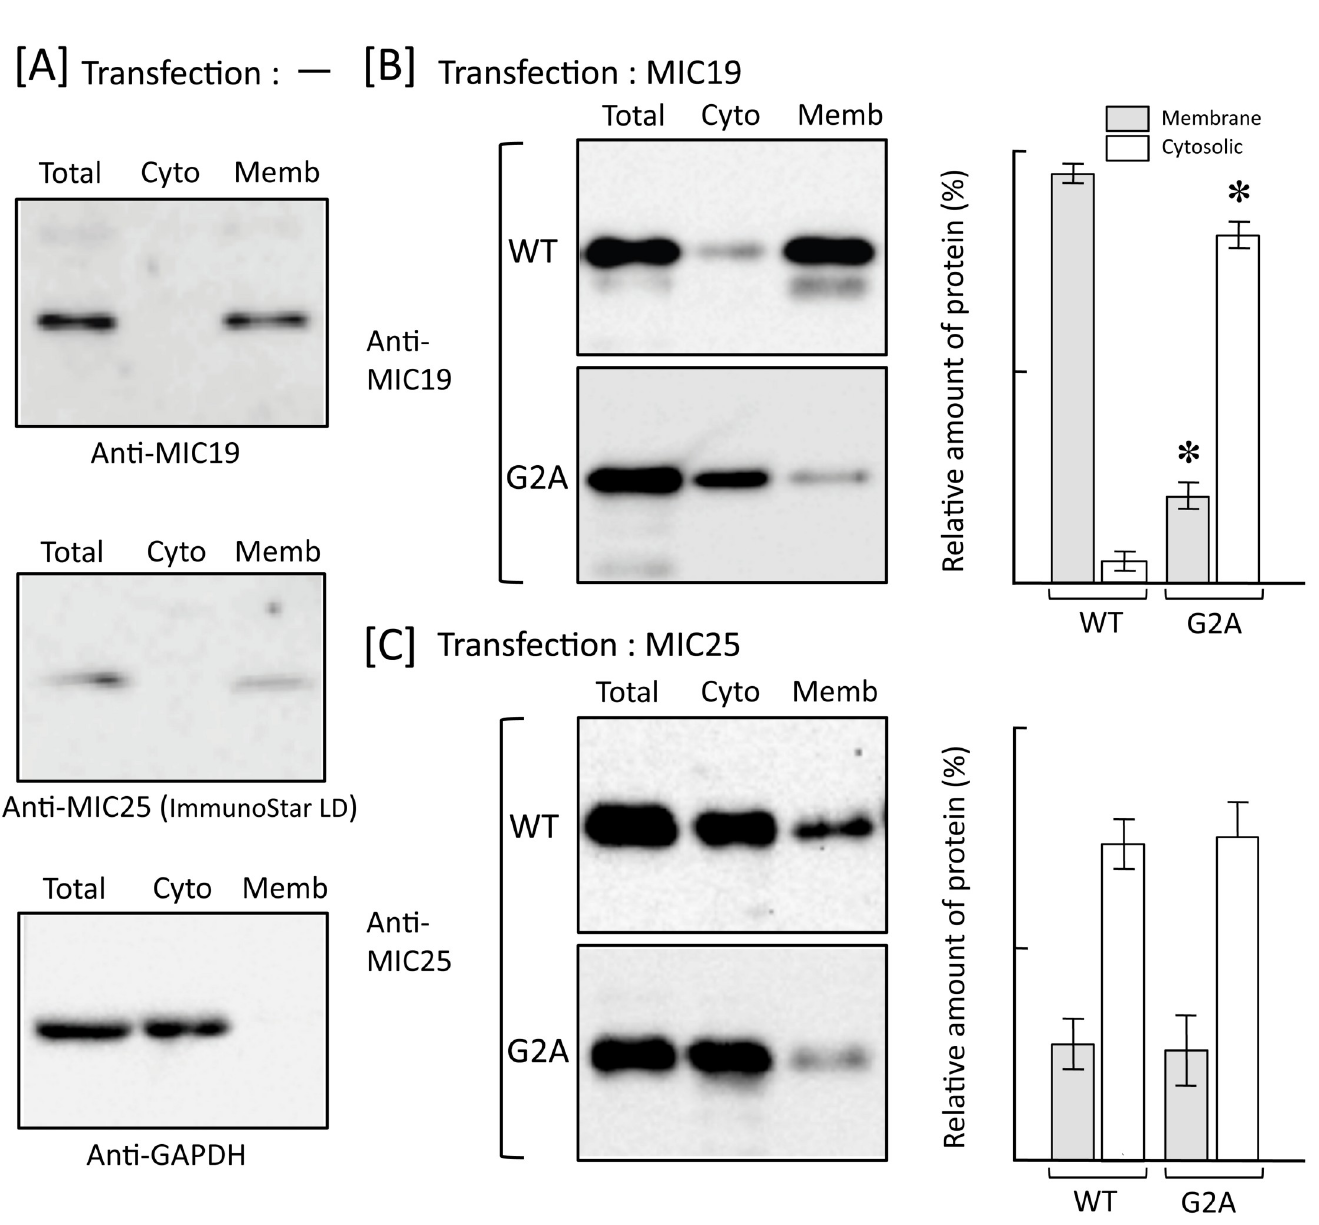
Fig 8. Protein N -myristoylation of MIC19 but not of MIC25 is required for binding of protein to the membrane. Total cell extracts of non-transfected COS-1 cells [A] and COS-1 cells transfected with cDNA encoding tag-free MIC19 [B] or MIC25 [C] were separated into cytosolic and membrane fractions by using membrane protein extraction kit (Trident). Presence of MIC19 and MIC25 in each fraction was determined by western blotting analysis using anti-MIC19 or anti- MIC25 antibody, respectively. For this analysis, anti-GAPDH antibody was used to detect GAPDH, a cytoslic marker protein [A]. For the analysis of COS-1 cells transfected with cDNAs coding for MIC19 [B] and MIC25 [C], relative amount of protein (%) reside in the cytosolic and total membrane fraction was calculated from densitometric analysis as described in materials and methods. Data are expressed as mean ± SD for three independent experiments. � P < 0.005 vs.